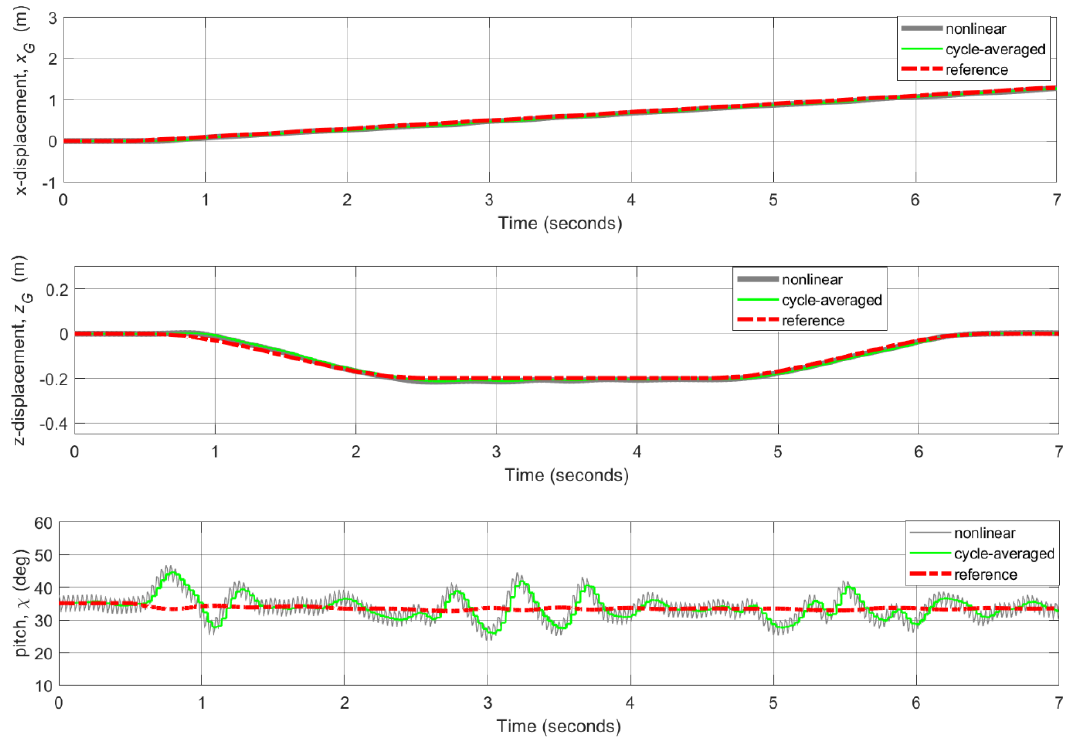
Figure 25. Flight control simulations for trajectories tracking control of nonlinear FWMAV model (case 2).